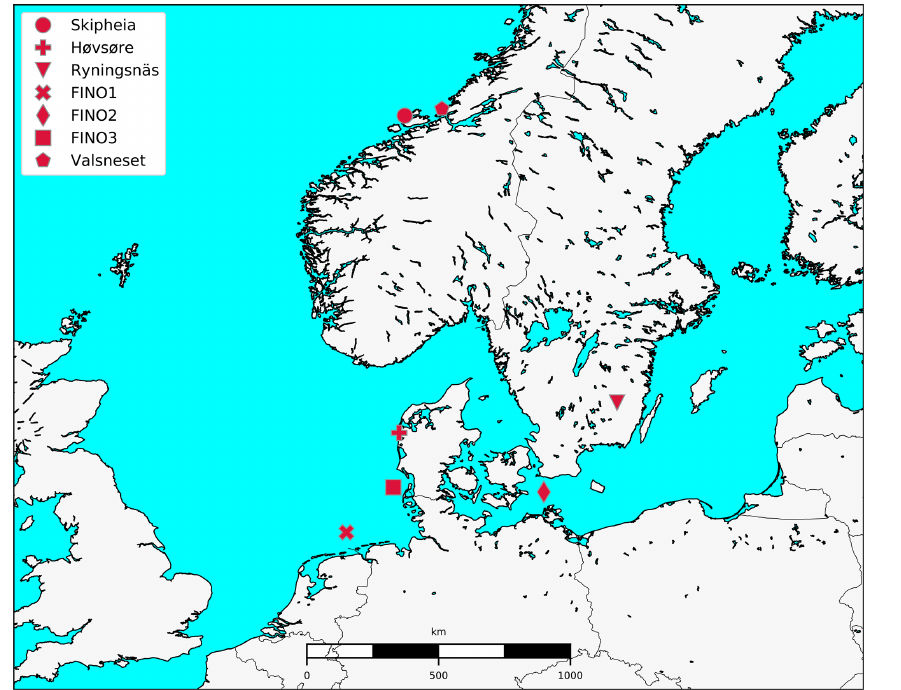
Figure 3. Map showing location of all sites used in this study.